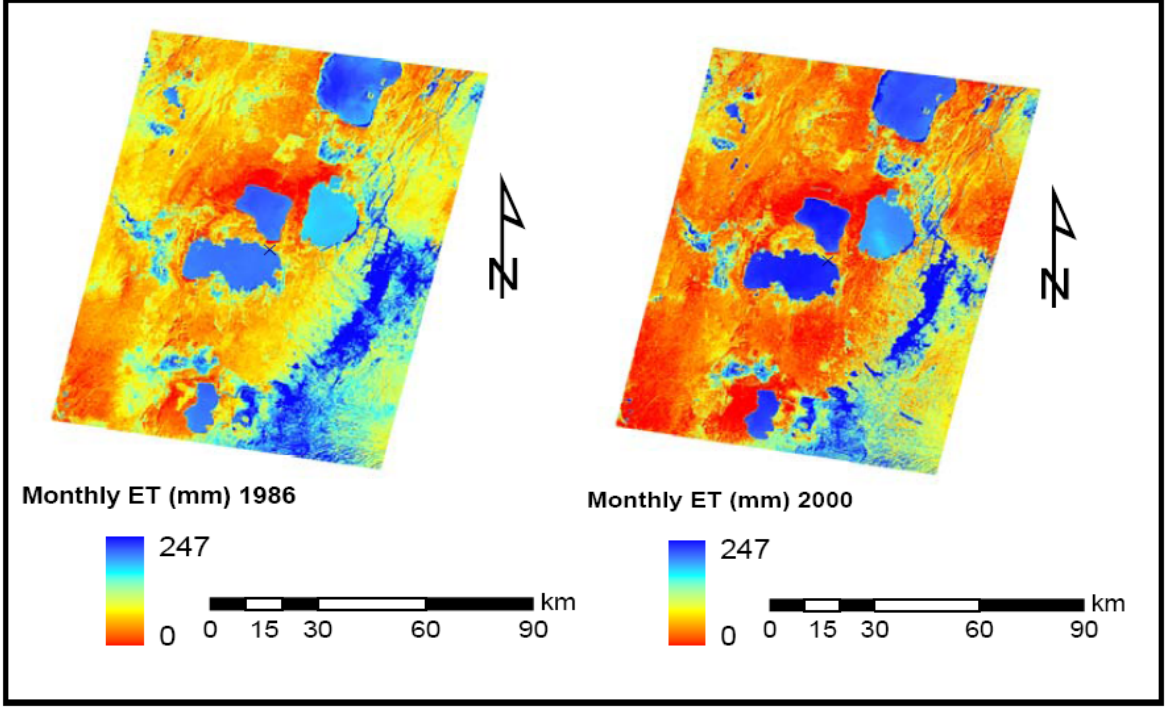
Figure 7. Spatial monthly evapotranspiration map of Rift valley lakes, Ethiopia.